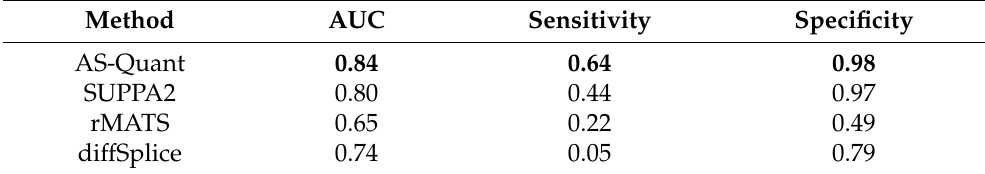
Table 1. Comparison among AS-Quant, SUPPA2, rMATS and diffSplice on simulated RNA-seq data. AUC score, sensitivity, specificity of the four methods are reported. The best results across the four methods are